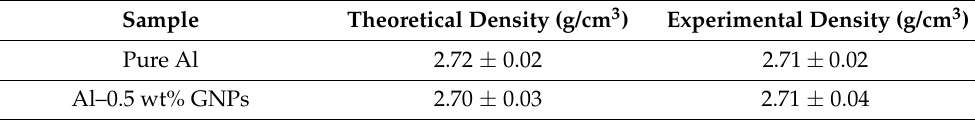
Table 2. Density variation of pure Al and Al–0.5 wt% GNP composite.